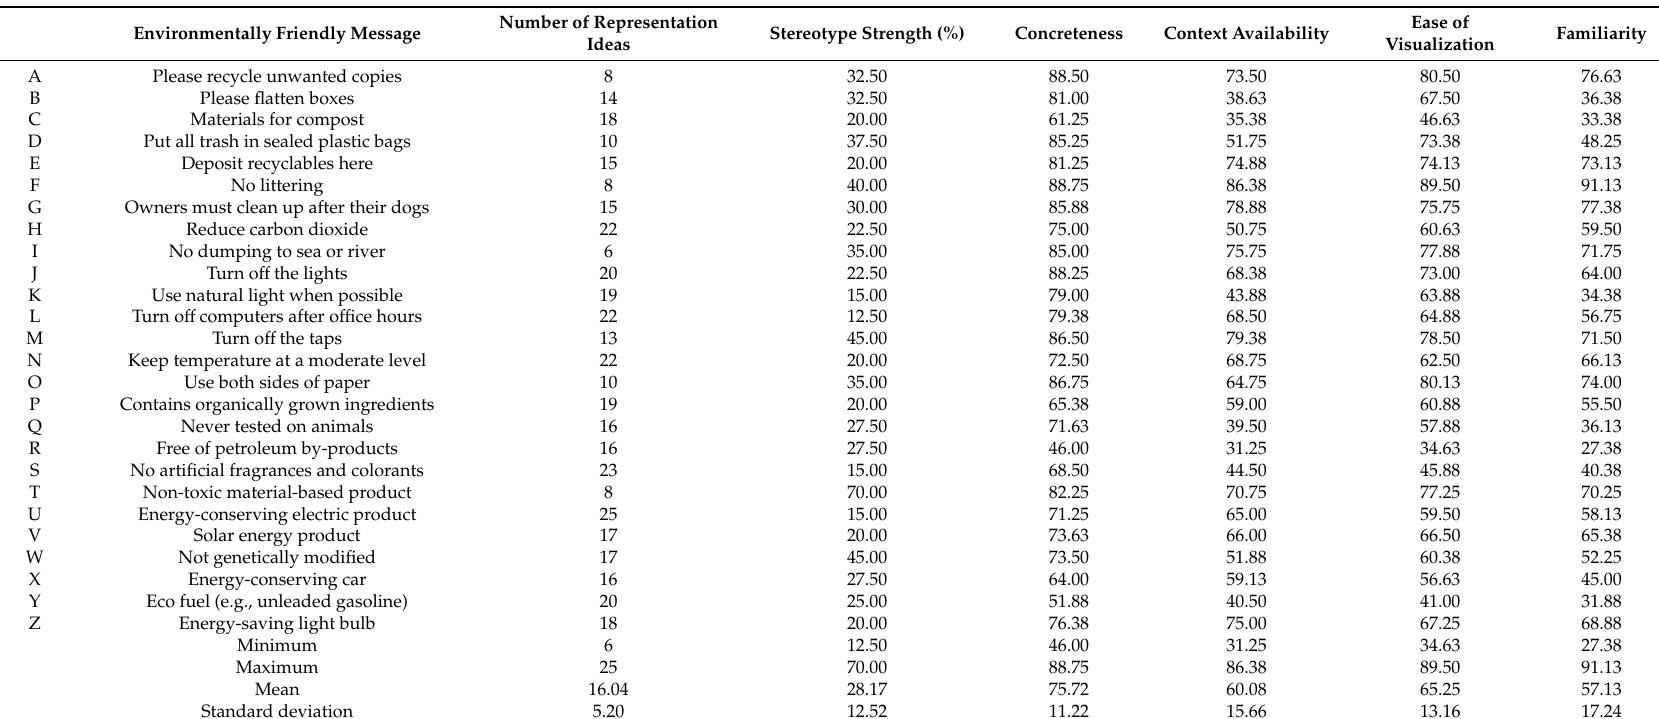
Table 1. Number of representation ideas, most common representations, strength of stereotype, concreteness, context availability, ease of visualization, and familiarity for the environmentally friendly